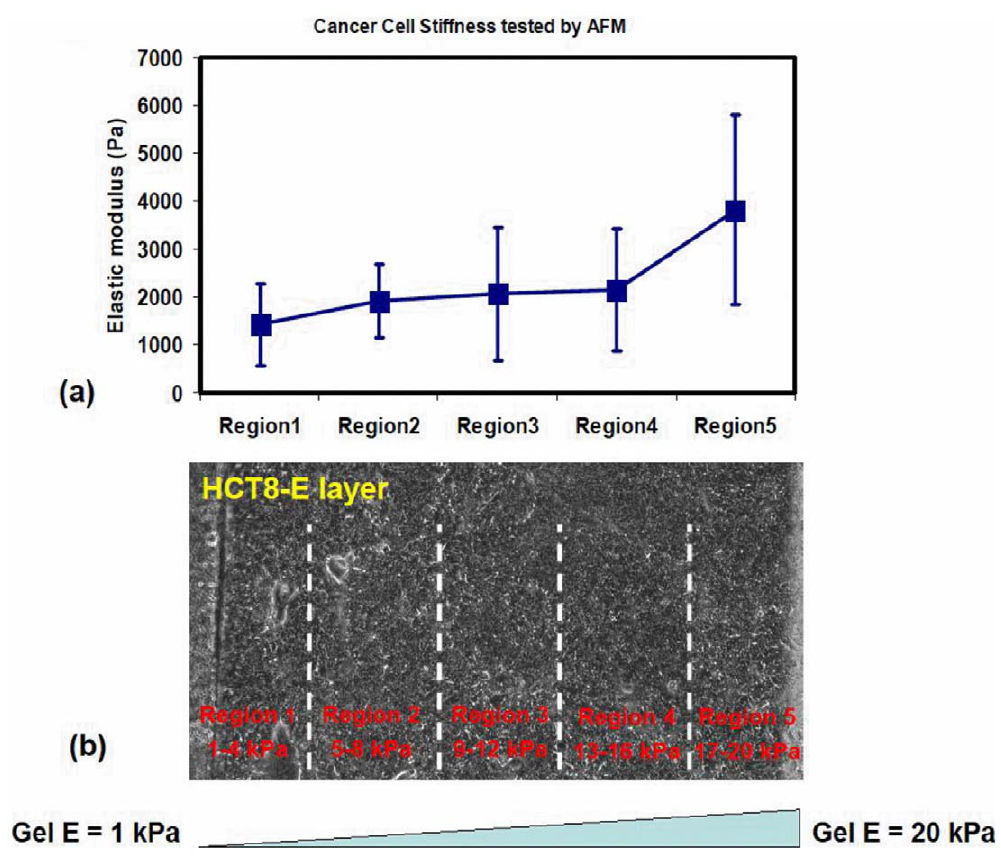
Figure 3. Stiffness and morphology of HCT-8 E cells correlate with substrate rigidity. Using Atomic Force Microscopy, the stiffness of HCT- 8 E cells cultured on the gradient substrate is determined. The HCT-8 E cells increase their cell stiffness as the substrates become more rigid. To facilitate the comparison between different cells on same substrate stiffness, five equal-spaced regions across the entire stiffness range are designated: region 1 covers 1–4 kPa, region 2 covers 5–8 kPa, region 3 covers 9–12 kPa, region 4 covers 13–16 kPa, and region 5 covers 17–20 kPa. (a) From region 1 to region 5, the E cell stiffness progressively increases with values 1.42 6 0.85 kPa to 1.90 6 0.77 kPa, 2.06 6 1.39 kPa, 2.15 6 1.28 kPa, and 3.82 6 1.98 kPa, respectively. In contrast, on gel substrates with same stiffness gradient, the post-metastatic R cells show almost invariant cell stiffness. (b) Phase-contrast pictures of HCT-8 E cells on gradient PA substrates.